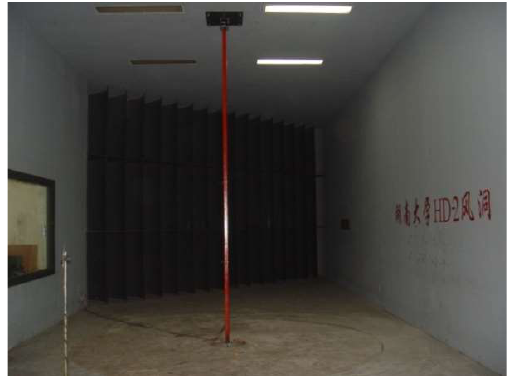
Figure 1. Wind tunnel test setup of the prototype prism.